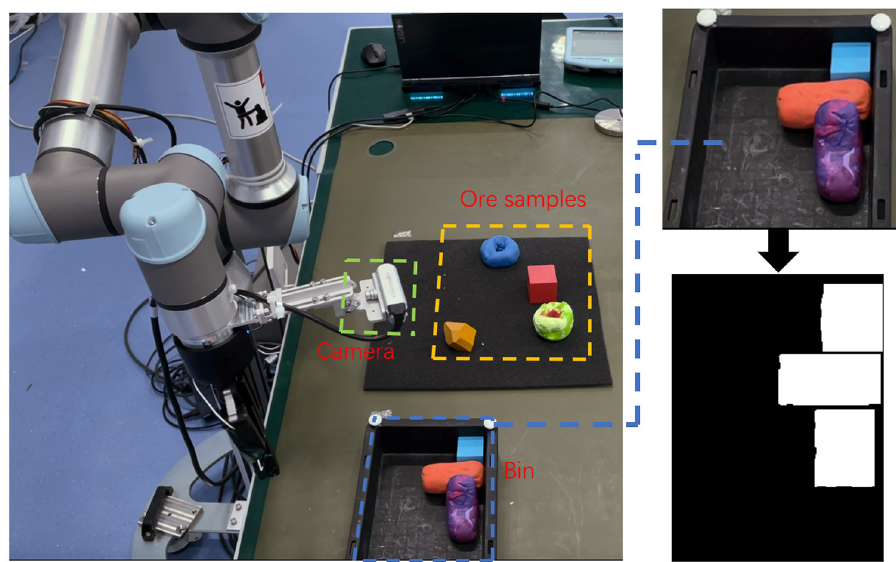
Fig 1. Experiment. In order to verify the effectiveness of the algorithm, an physical experiment is carried out in this paper. Use a robotic arm to collect samples and place them into a bin. The top view of the bin is obtained by hand-eye camera, and then the top view is converted into a binary image.